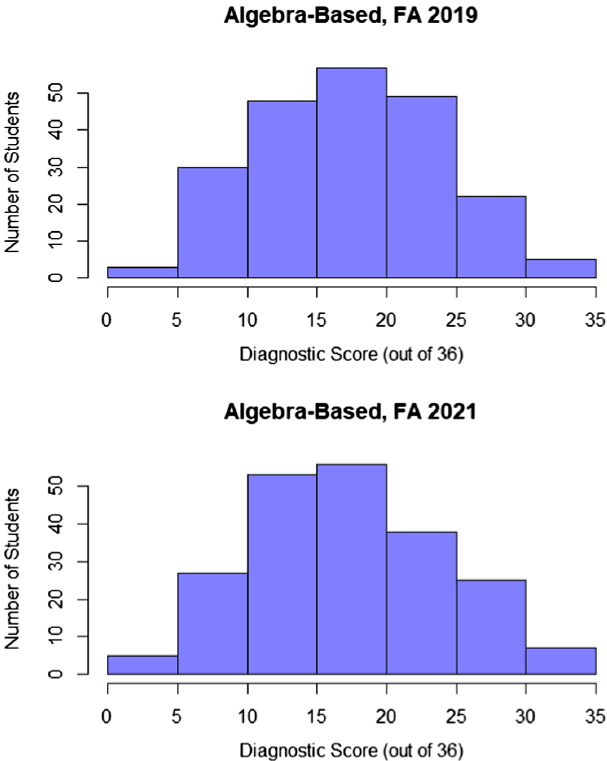
FIG. 2. Score distribution in 2019 (top) and 2021 (bottom) for students intending to enroll in calculus-based